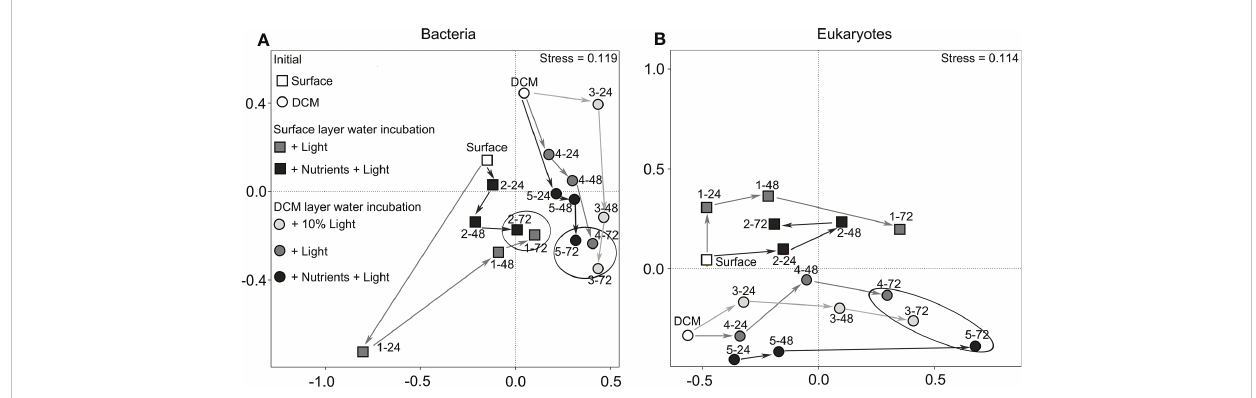
FIGURE 5 Non-metric multidimensional scaling (NMDS) ordination showing the community structure of bacteria (A) and eukaryotes (B) differentiated on the time course: surface water incubation (circle), DCM layer water incubation (square), + 10% light group (in light gray), the + light group (in gray), the + nutrients + light group (in dark gray). The white circle/square marks represent the initial. There were large differences among the incubation